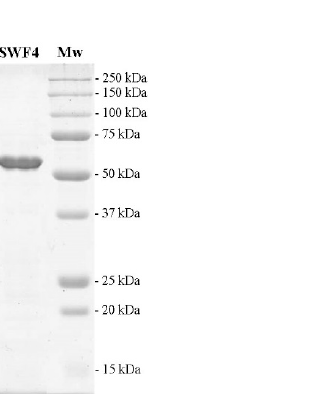
Figure 3. 12% Sodium dodecyl sulfate (SDS) ‐ electrophoresis of purified recombinant sulfatases SWF1 and SWF4. MW: molecular weight. and SWF4. MW: molecular